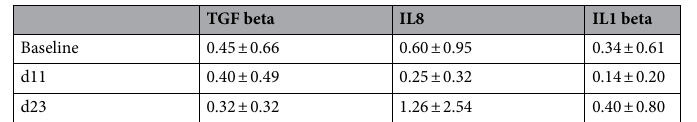
Table 5. Levels of expression of cytokines (TGF beta, IL8 and IL1 beta) in bronchial brushing samples. Levels of gene expression (mean ± SD) reflect ratios relative to a housekeeping gene (ATPase). The data were analysed by repeated measures ANOVA to determine the influence of time, with sheep identity included as a random factor. Levels of cytokine expression did not differ significantly (P > 0.05) between time